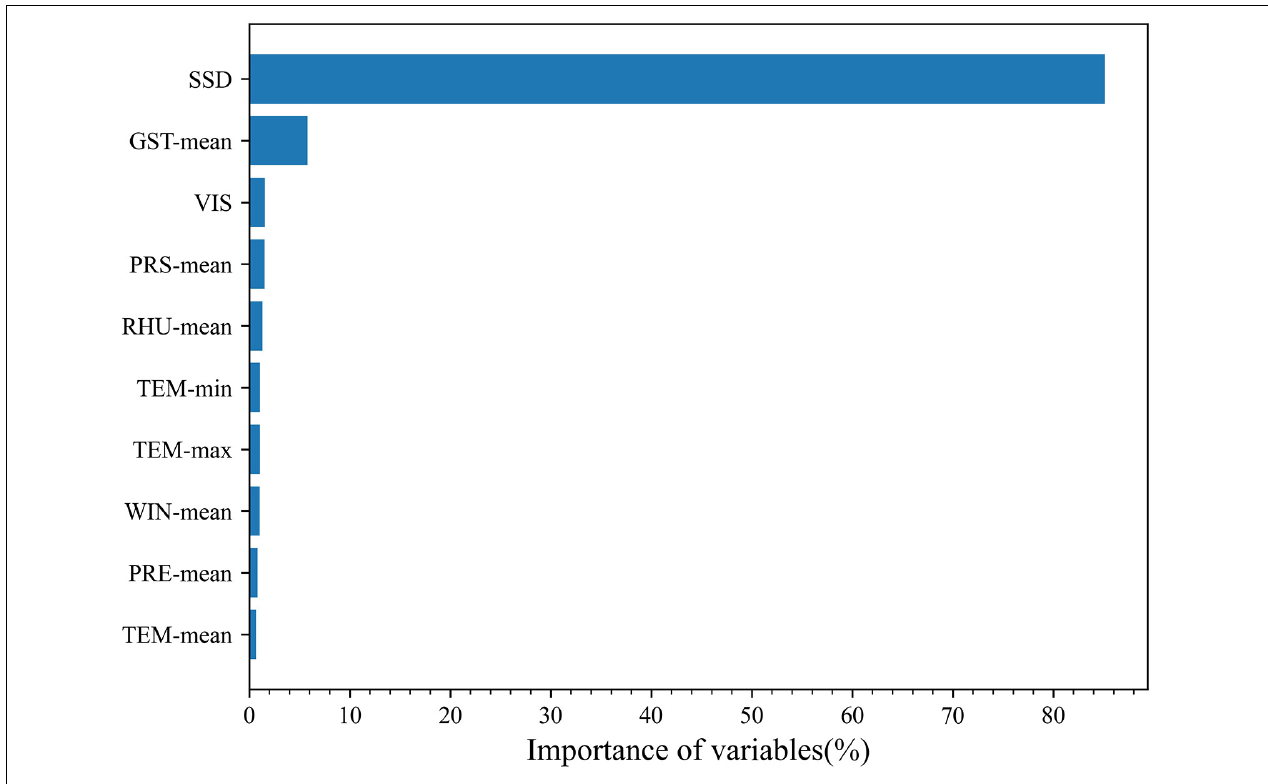
FIGURE 5 | Importance of variables in predicting solar radiation using the random forest model.